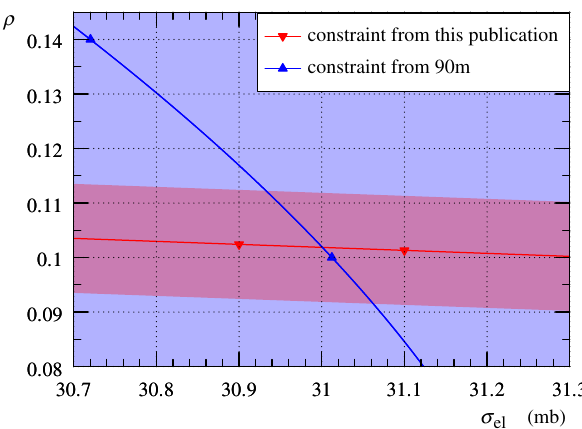
Fig. 17 Constraints to the relation between ρ and σ el derived from this data set (red line) and from Ref. [6] (blue